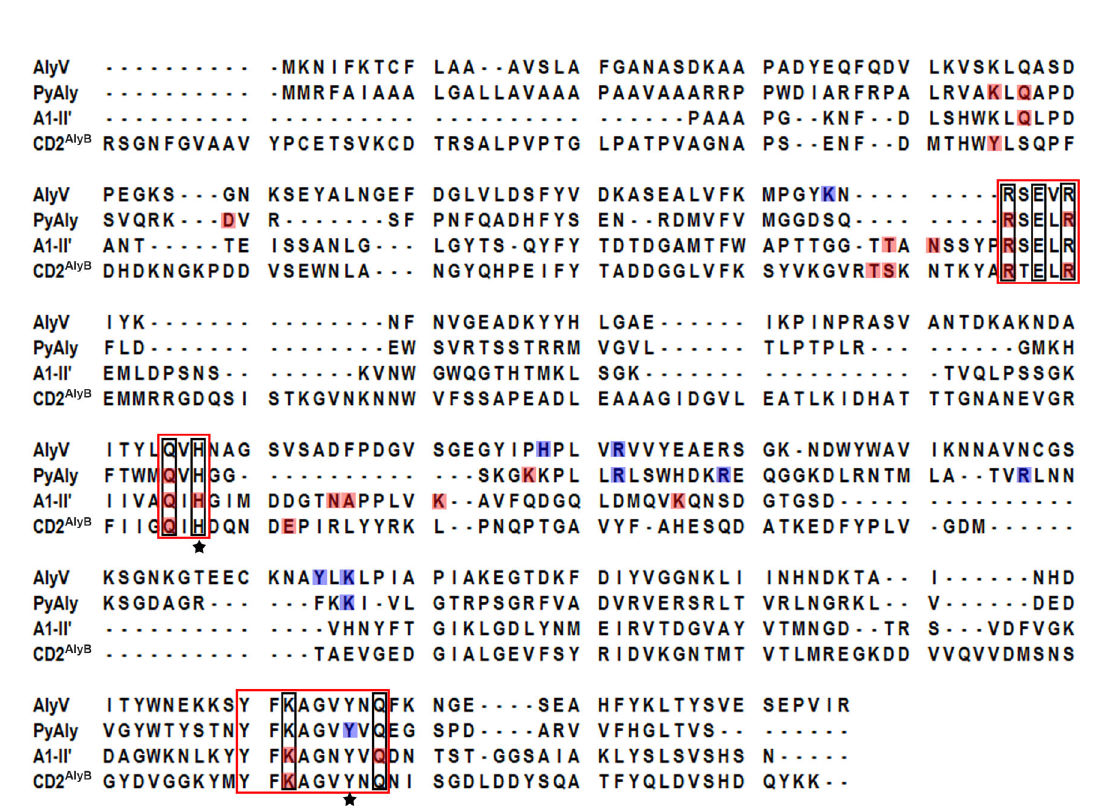
Fig. 3 Sequence alignment of AlyV, PyAly, A1-II ’ and CD2 AlyB . The three conserved regions in the PL7 family are boxed in red, and two conserved catalytic residues are marked with stars. For PyAly, A1-II ’ and CD2 AlyB , the residues involved in substrate binding at subsites + 1 to + 3 are shaded in red, and the conserved residues in the PL7 family are boxed in black. For PyAly and AlyV, the residues involved in substrate binding at subsites -1 to -3 are shaded in